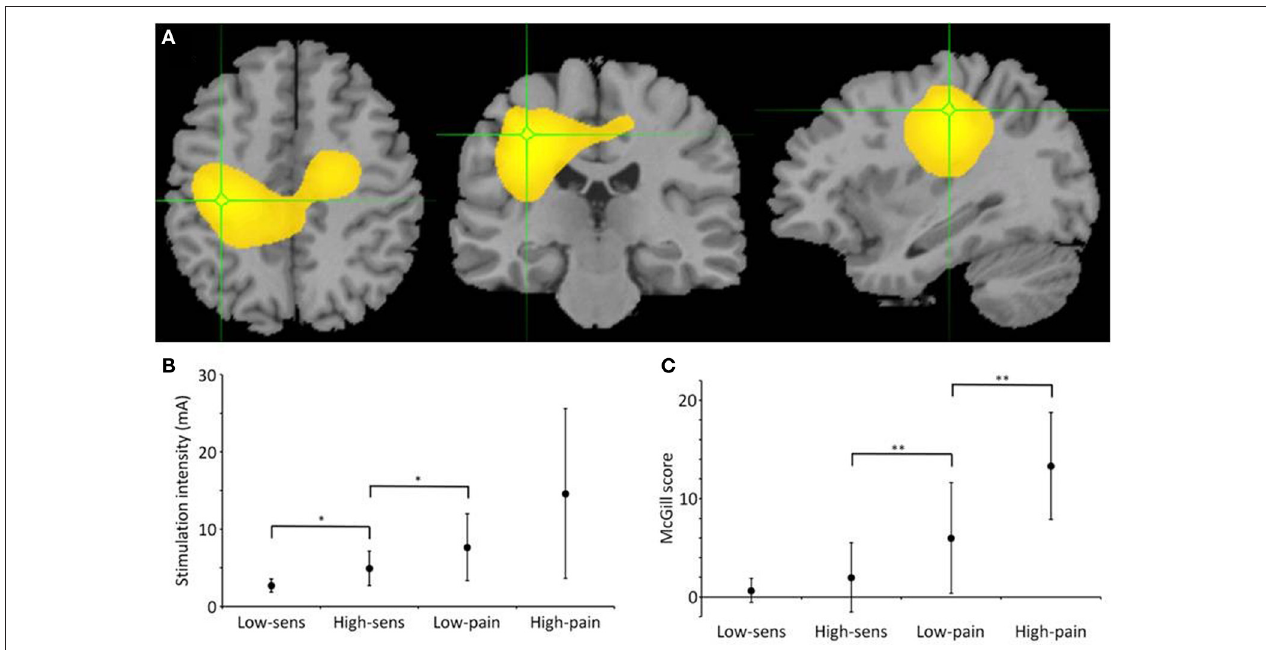
FIGURE 1 | Gamma source localization, stimulation and pain intensities. (A) Average map of change in gamma across participants, located in post-central gyrus (Talairach coordinate = − 33.1, − 24.1, 45.0) (B) Graph showing actual stimulus intensity used at each level in mA. Significant